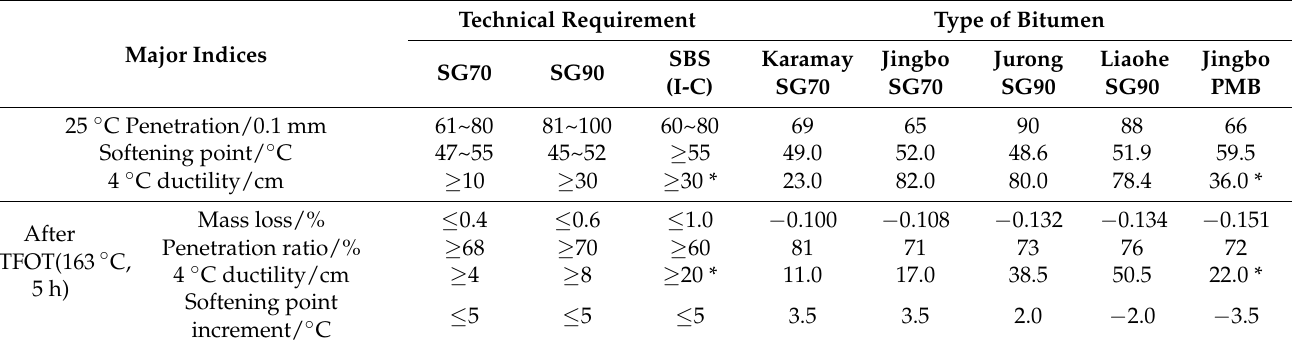
Table 1. Basic properties of five hydraulic bitumen